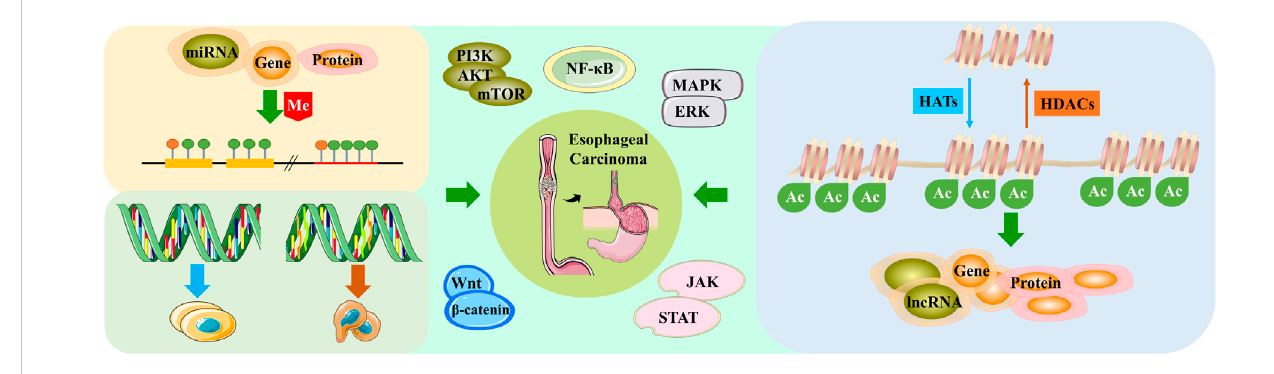
FIGURE 2 Esophageal cancer regulates cancer-related pathways through different epigenetic modi fi